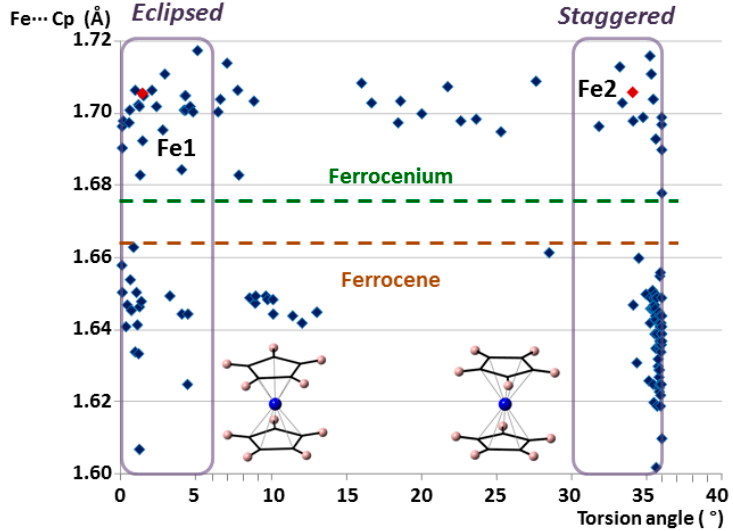
Figure 4. Plot of the average Fe···Cg(Cp) distances vs torsion angles for all the ferrocenyl moieties included in the search within the CSD database. The non-disordered crystallographically independent ferrocenyl units in 1 are indicated in red.